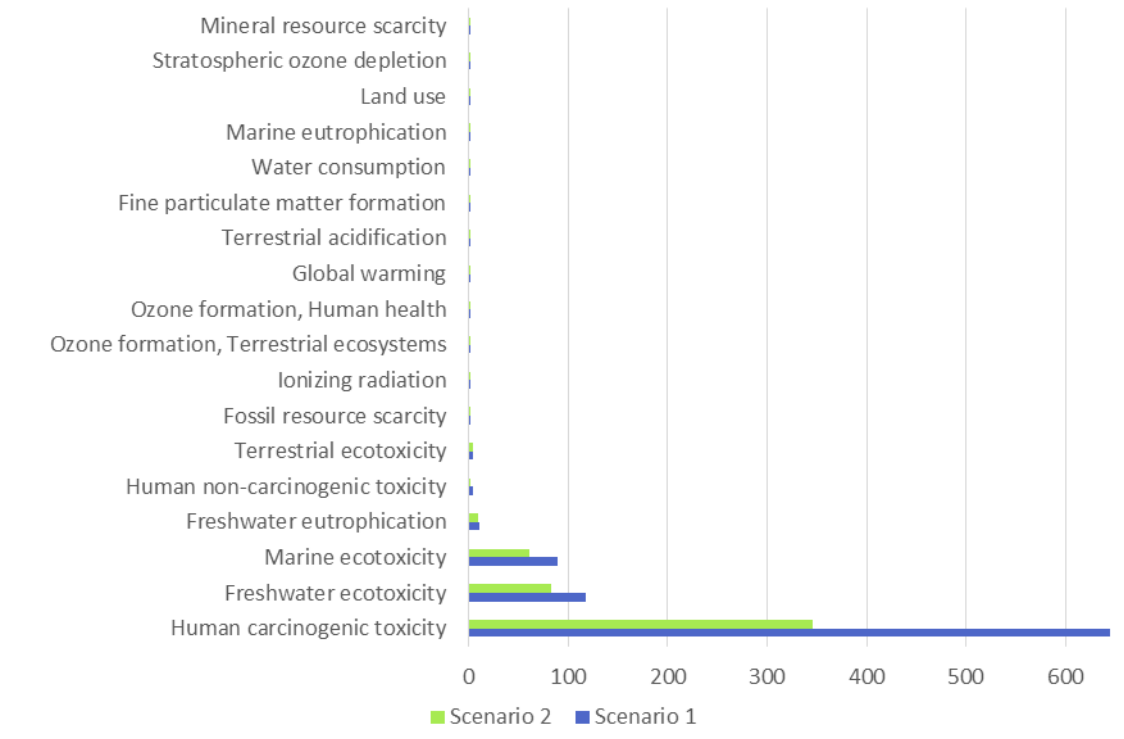
Figure 6. Comparison of the environmental performance of both studied scenarios in terms of their dominance in damage assessment categories available in the ReCiPe 2016 Endpoint (H) method.